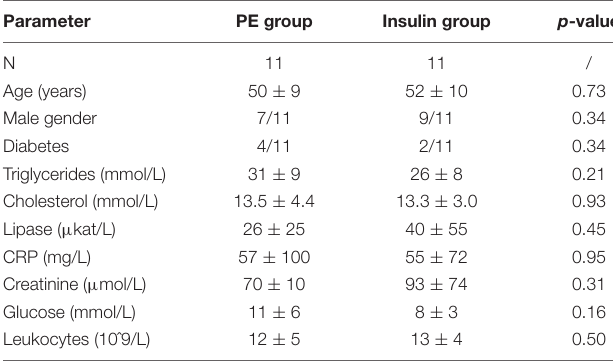
TABLE 1 | Patients’ baseline characteristics and laboratory results in plasma exchange (PE) and insulin